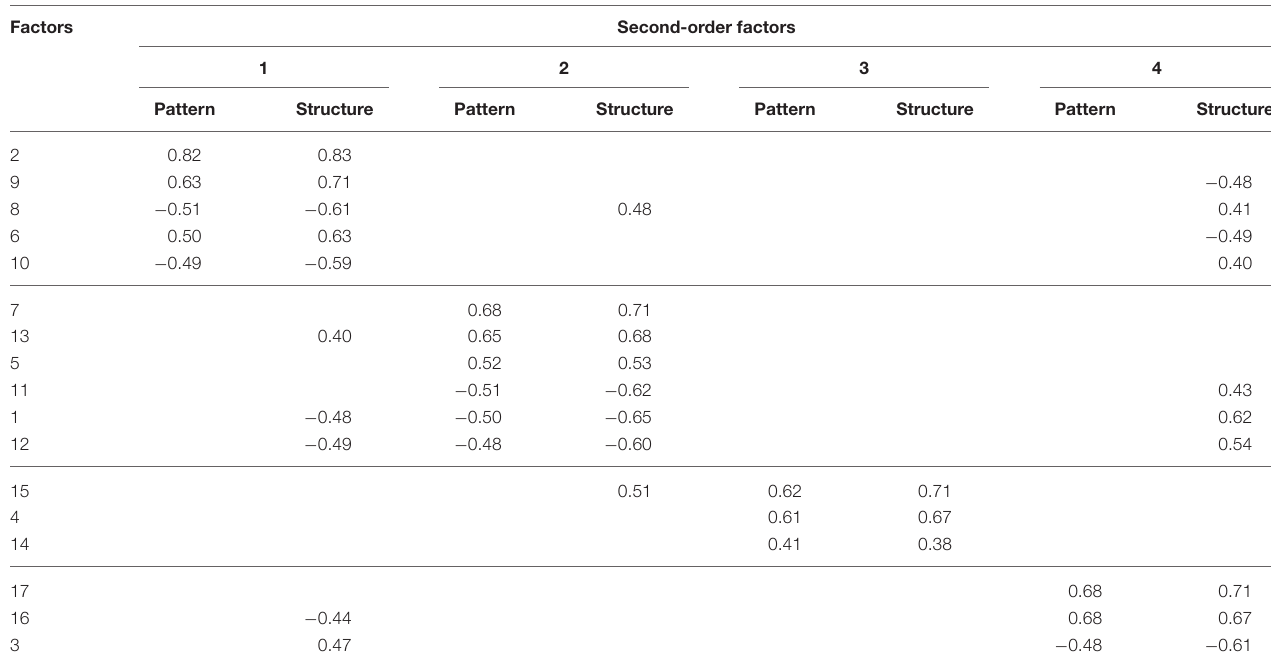
TABLE 5 | An EFA of the obtained 17 factors. Factors Second-order factors